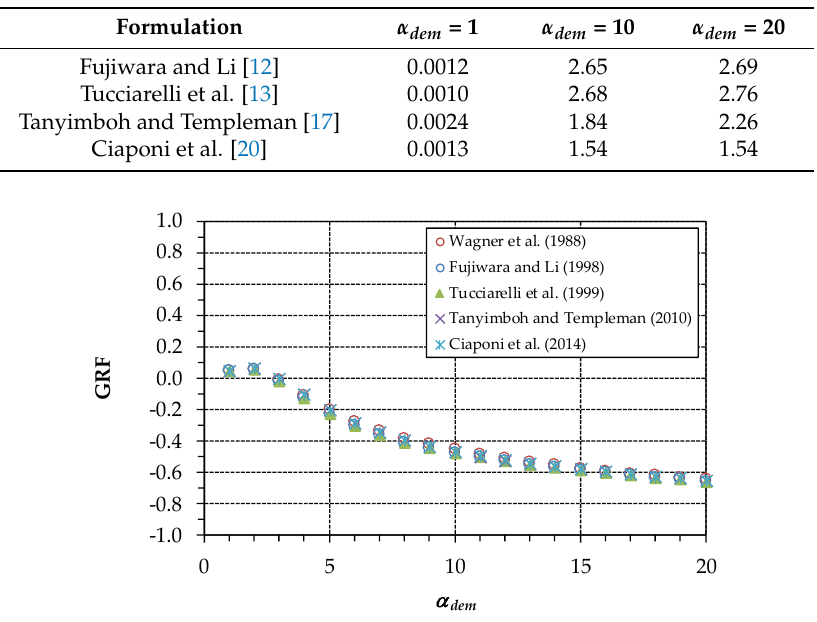
Figure 7. First case study. Generalized resilience/failure index (GRF) for the various formulations as a function of α dem .